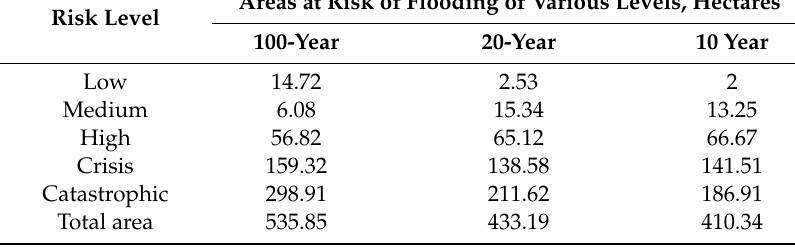
Table 11. Areas a ff ected by the floods of di ff erent return periods for the settlement Zhibek Zholy (Classification